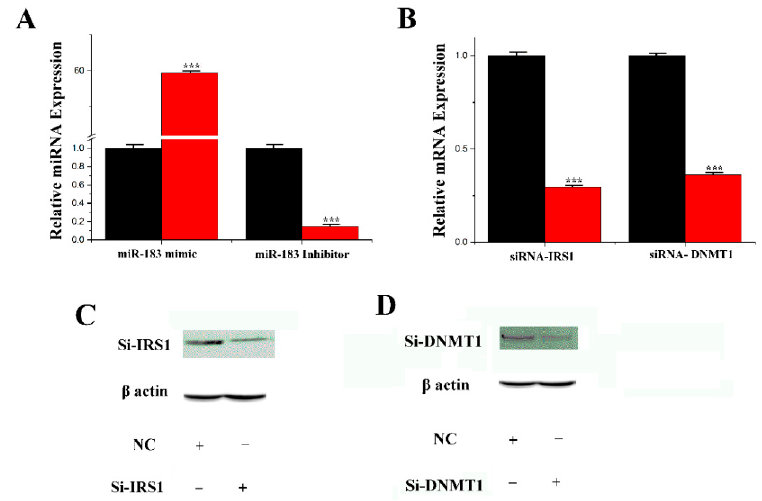
Figure 4. The e ff ect of miR-183 and siRNA. ( A ) miR-183 expression levels in cells transfect with miR-183 mimic or inhibitor; miR-183 expression levels in transfected cells were compared with that of miR-183 controls ( n = 6). Red bars represent the negative control; black bars represent miR-183 mimic or inhibitor; ( B ) The expression of IRS1 or DNMT1 was quantified by RT-qPCR ( n = 6); ( C , D ): Si-IRS1 or DNMT1 protein expression was evaluated by Western blot in CMECs. Values are presented as means ± standard deviation, *** p <